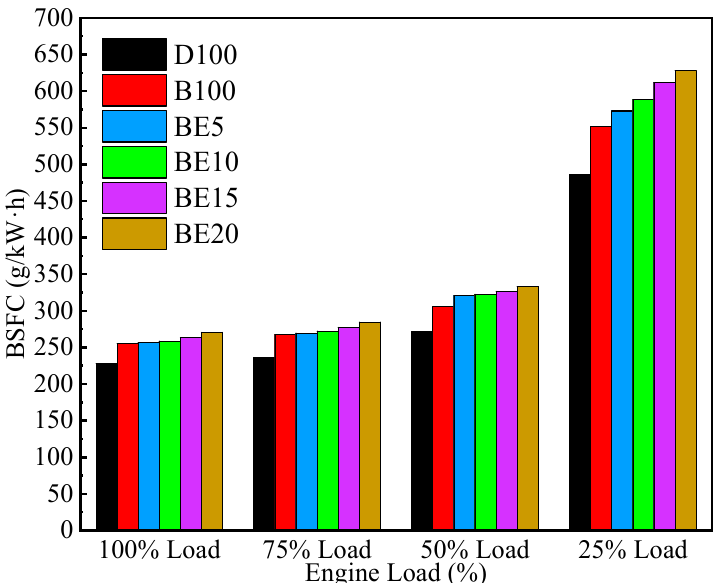
Figure 9. Comparison of BSFC for different fuels at different loads.